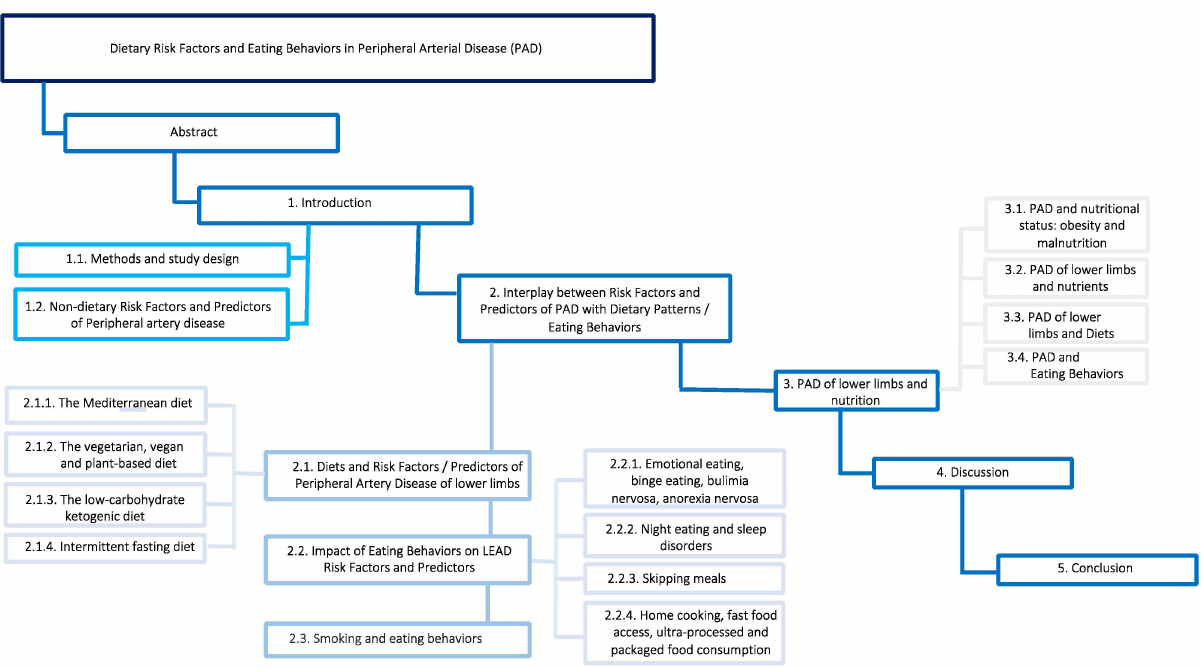
Figure 1. Methods and study